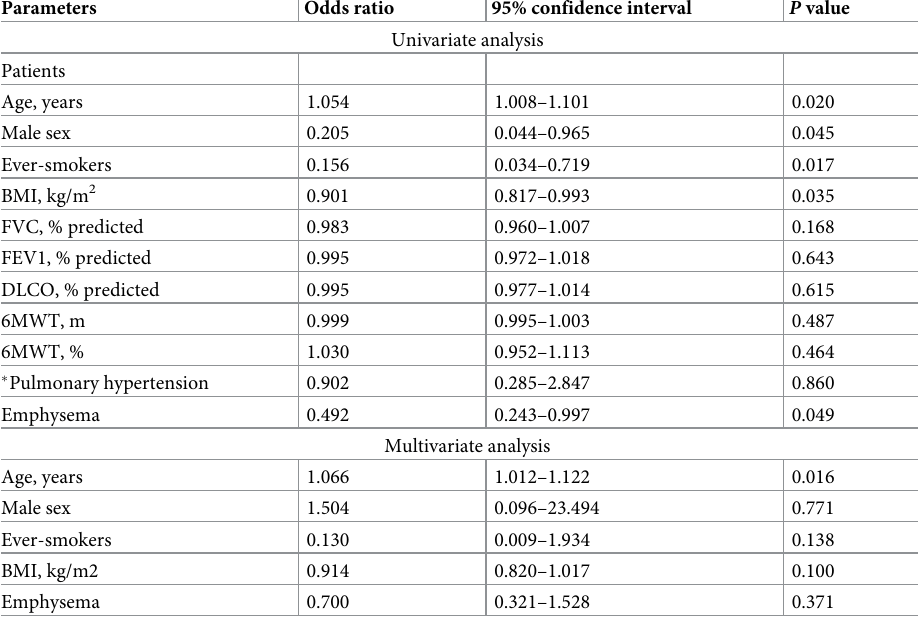
Table 3. Factors associated with dose reduction of